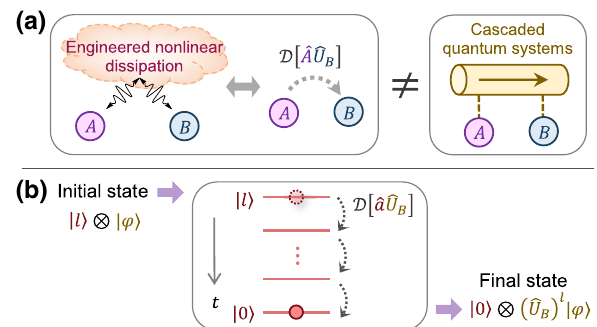
FIG. 1. (a) Schematic for quantum nonreciprocal interactions via gauge symmetry. This approach uses correlated dissipation, but is completely distinct from a cascaded quantum system. (b) Dissipative steady-state realization of a tunable unitary gate mak- ing use of the nonreciprocal interaction in (a), in a system where subsystem A is a cavity mode a that controls the gate, and sub- system B is the target qubit. One can selectively apply a unitary gate ( ˆ U B ) (cid:3) on B by initializing A in the corresponding Fock state | (cid:3) (cid:3) , and letting the system relax to the steady state [see Eq. (3) and Sec. III